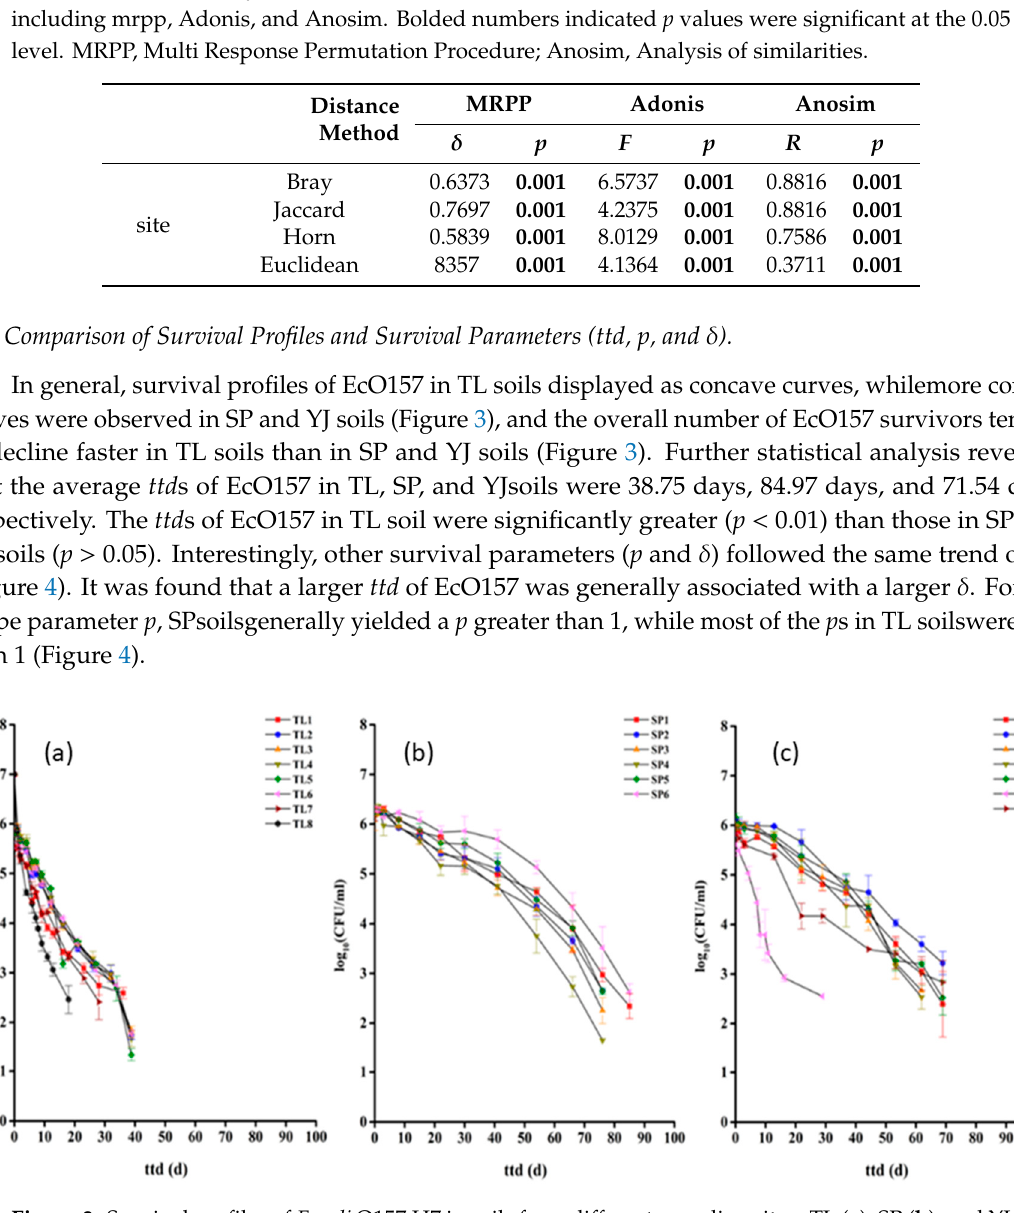
Table 1. Dissimilarity analysis of fungal community structures in different types of soil. The distance metrics used were Bray, Jaccard, Horn, and Euclidean. Three distance indices were calculated, including mrpp, Adonis, and Anosim. Bolded numbers indicated p values were significant at the 0.05 level. MRPP, Multi Response Permutation Procedure; Anosim, Analysis of similarities.